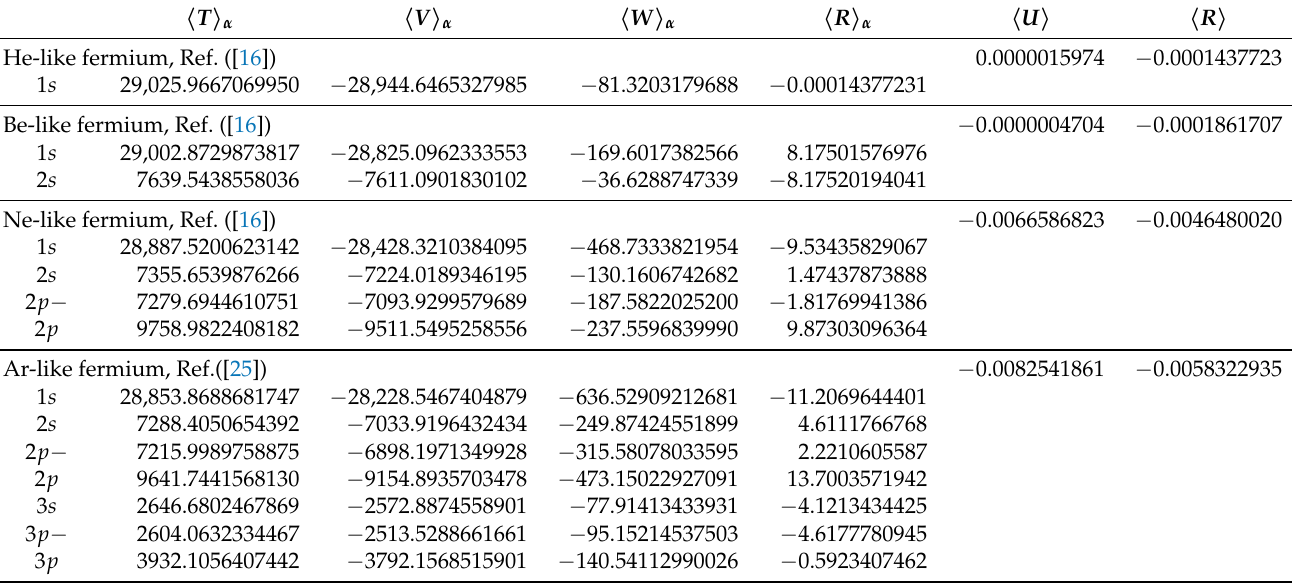
Table 5. Trends in dilation data (all in E h ) for the ground state of ions of Fm ( Z = 100 ) with increasing number of closed shells obtained using DBSR_HF (Ref. ([16])) or G RASP (Ref.([25])). We report residuals for subshell equations, (cid:104) R (cid:105) α = (cid:104) T + V + W (cid:105) α , the dilation correction for the total